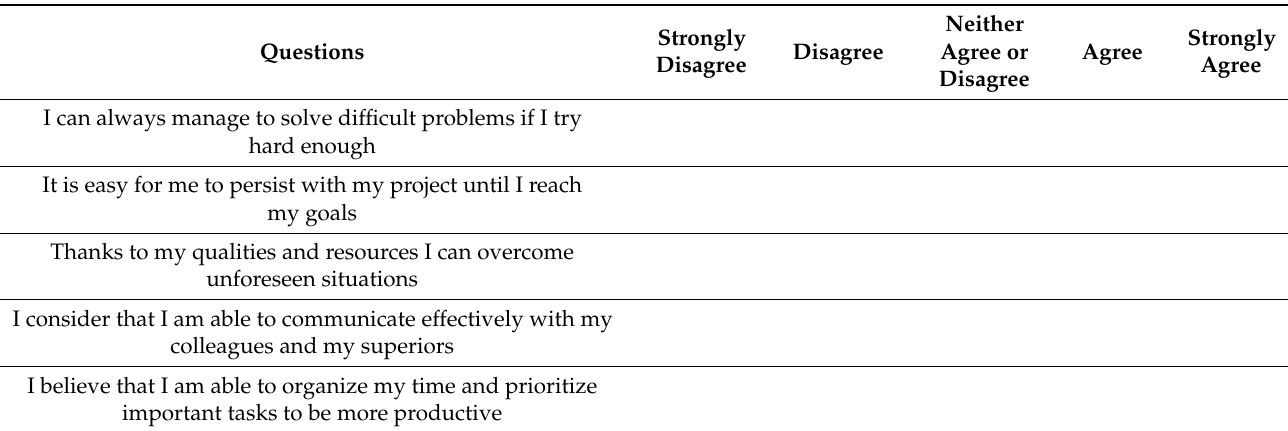
Table A1. GloPEW composition and